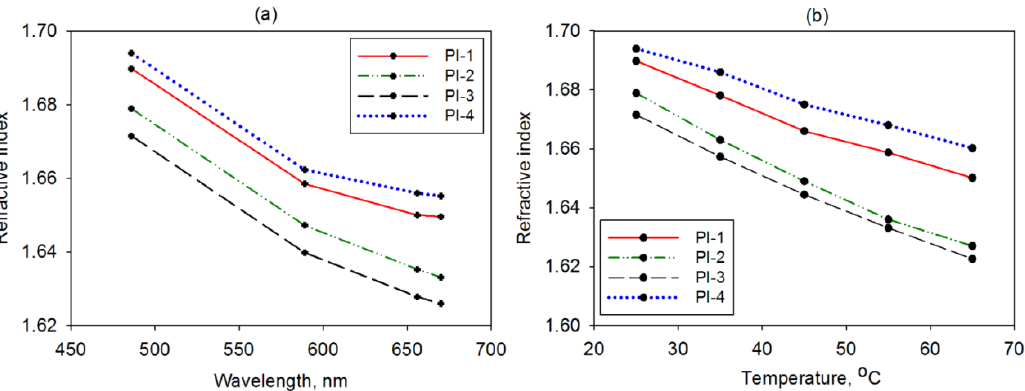
Figure 4. The variation of the refractive index with ( a ) a wavelength at 25 °C and ( b ) temperature at 486 nm for the PI-1, PI-2, PI-3, and PI-4